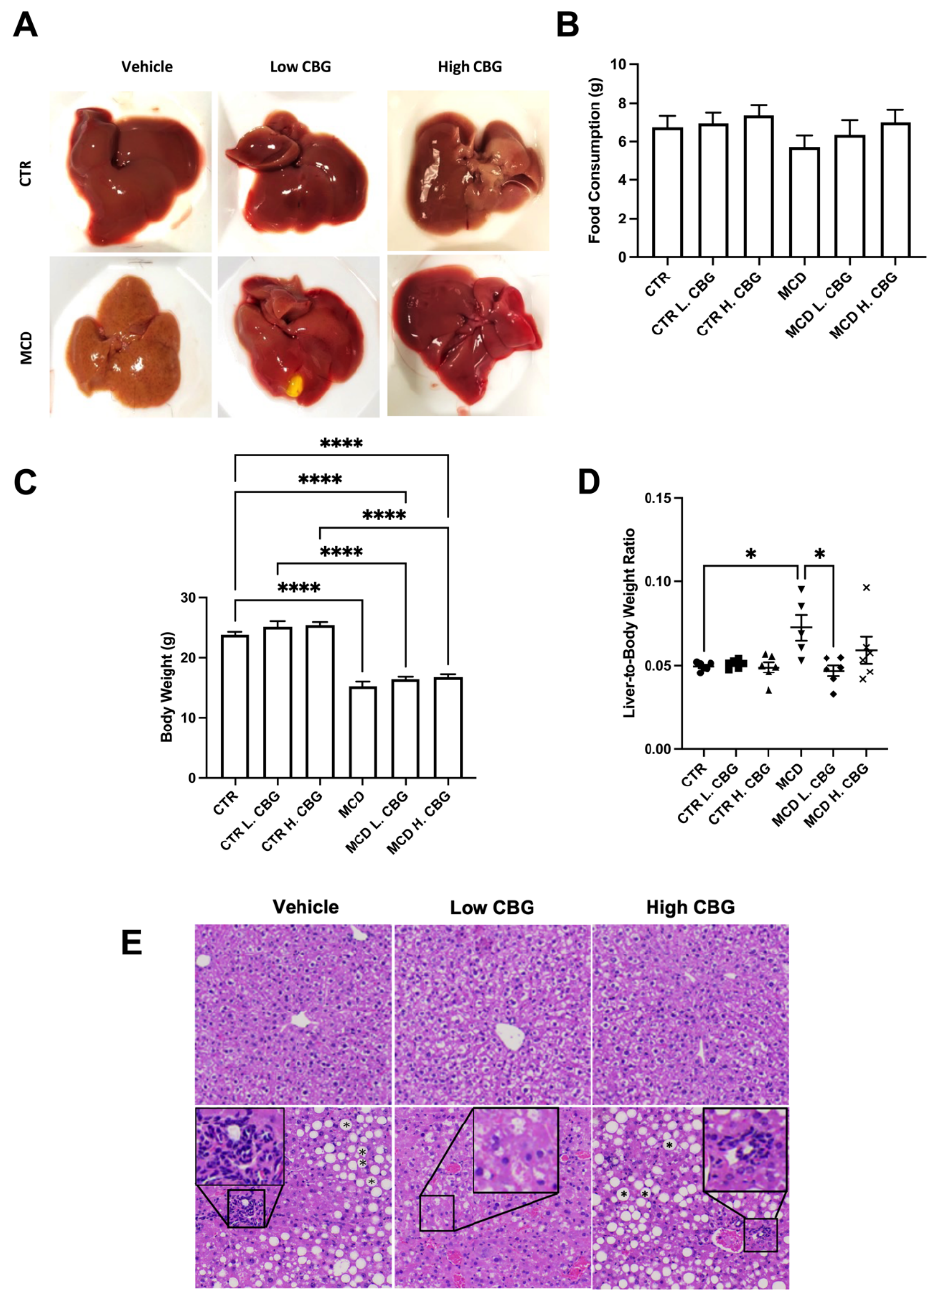
Figure 1. Evaluation of the overall liver health with the induction of NASH using MCD diet and role of CBG in reducing the liver damage. Representative images of liver post-harvest to illustrate the differences in morphologies between groups ( A ) Average total food consumption ( B ), Body Weight ( C ) and average liver weight-to-body weight ratio ( D ) was calculated among groups. Representation of the liver after being stained with H&E ( E ), showing lipid accumulation (mark as asterisk in hepatic ballooning area) and white blood cells infiltration (enlarged area) with the MCD diet (bottom row). * p < 0.05, **** p < 0.0001.